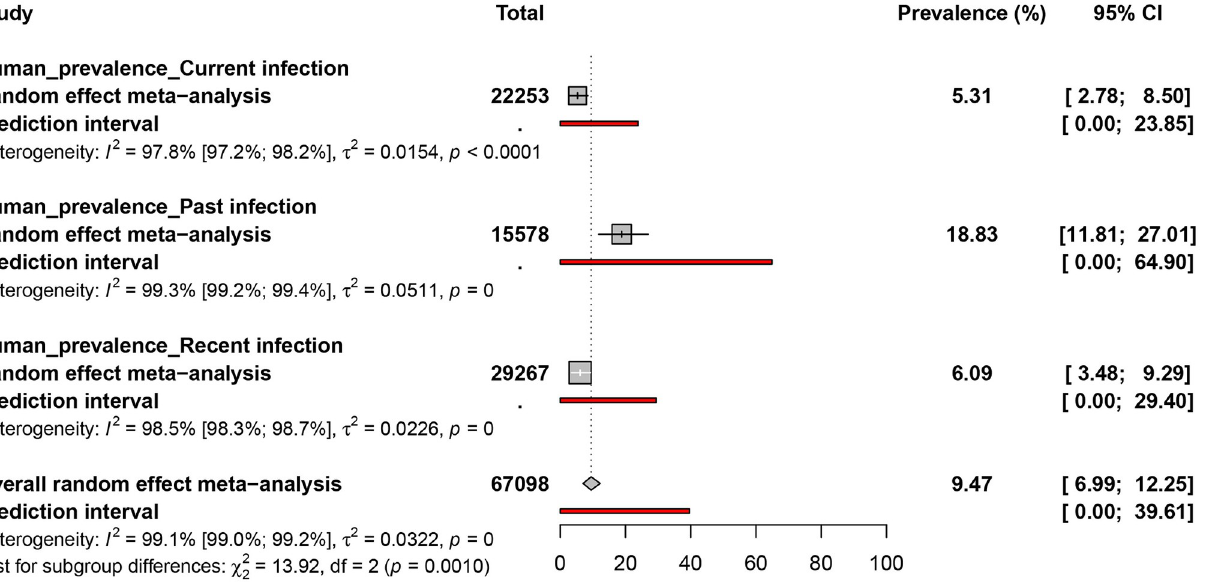
Fig 4. Prevalence estimates of yellow fever virus infections in humans in sub-Saharan Africa.